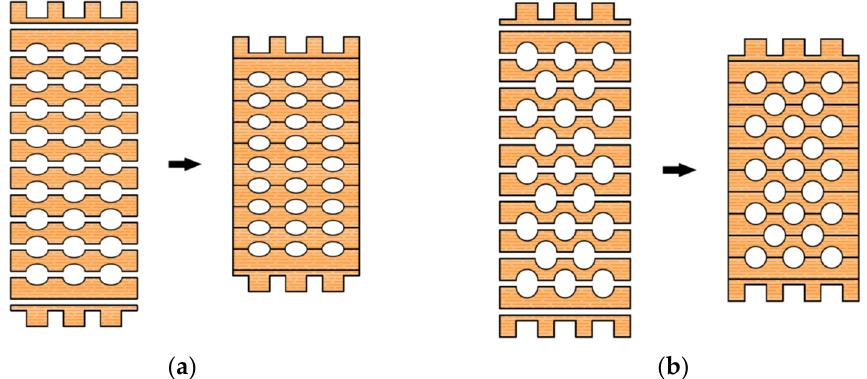
Figure 9. Glue-laminated hollow timber elements: ( a ) elliptical cavities; ( b ) circular cavities.